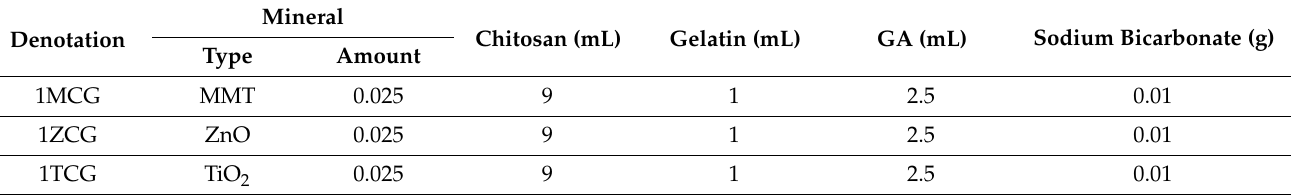
Table 1. Denotation and specification of CS/gel/mineral porous gel.